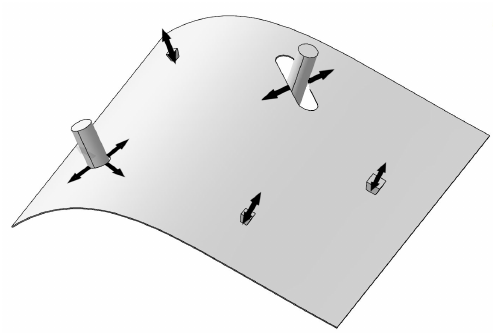
Figure 1. A fixture layout for a single sheet metal part and the locking direction of each locator